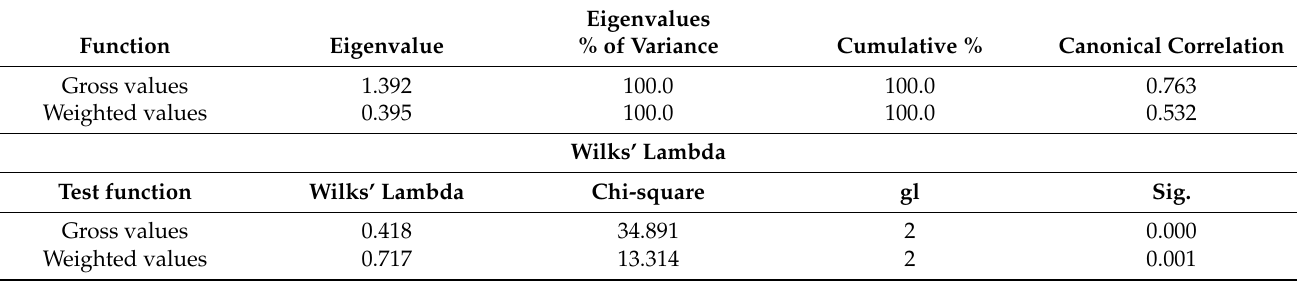
Table A6. Summary of the canonic discriminant